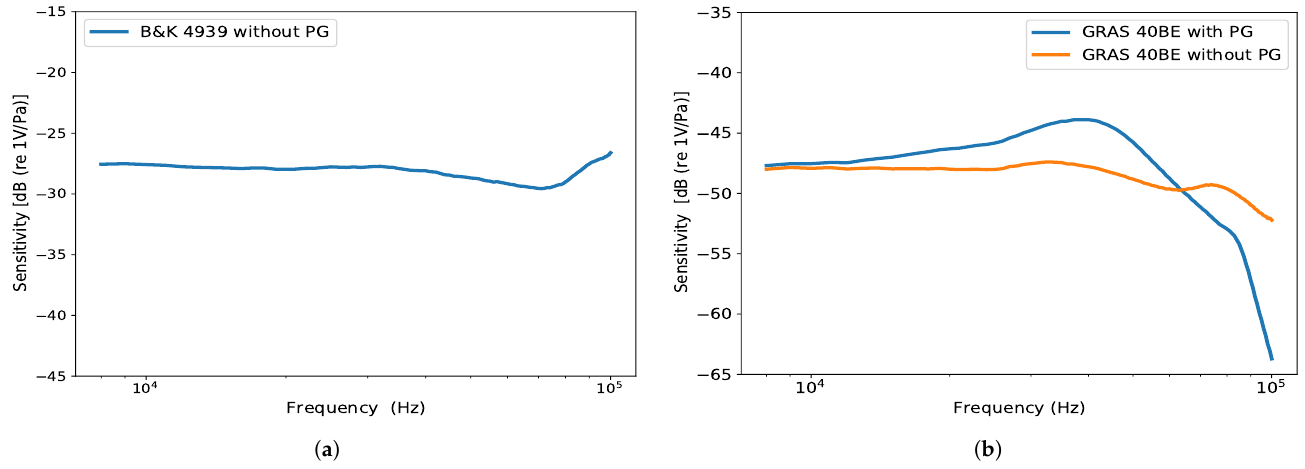
Figure 9. Frequency response of the microphones used in this study ( a ) The frequency response of B&K 4939 microphone, when measured with the protection grid (PG) and ( b ) The frequency response of GRAS 40 BE microphone, when measured with and without